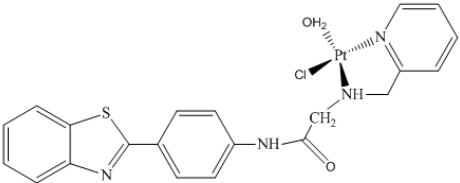
Figure 1. Cis-dichloro(2’pyridinyl)methylamineplatinum(II) bonded to 2-(4’aminophenyl)benzothiazole derivative (Complex 1).